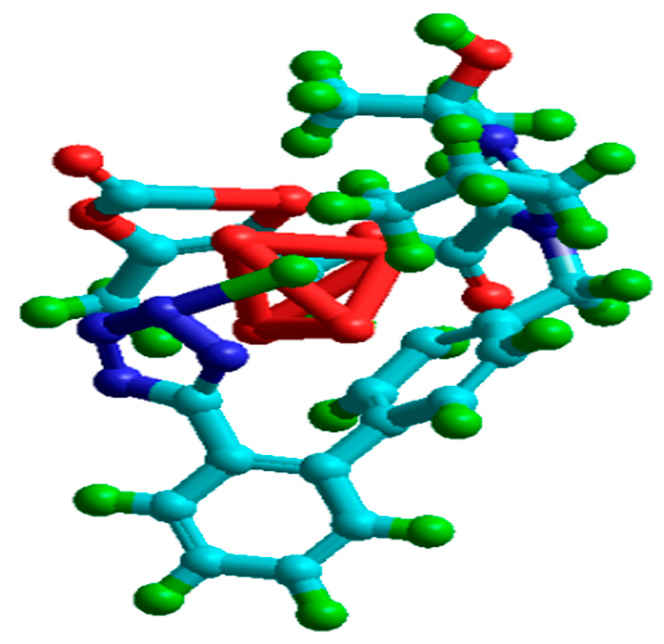
Figure 5. Interaction of Fe (110) with olmesartan